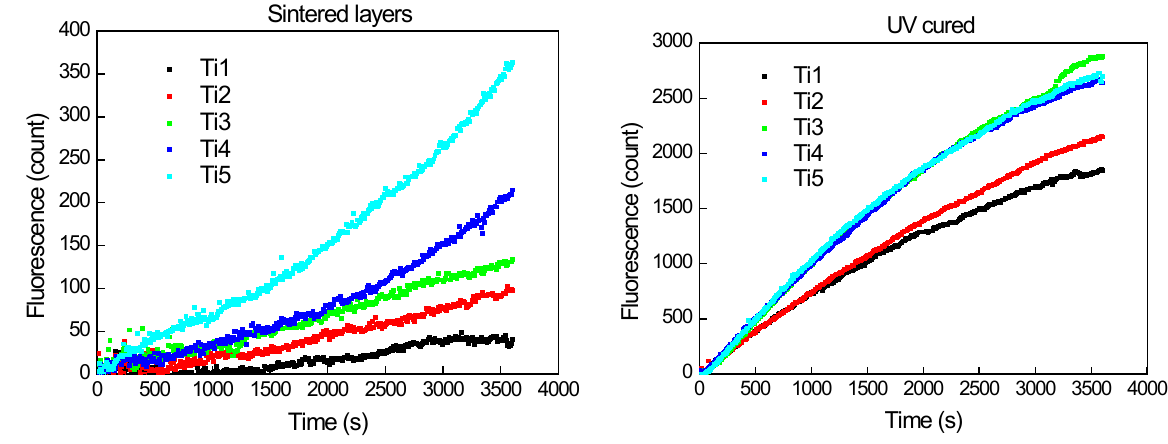
Figure 9. Records of hydroxyterephtalic acid fluorescence intensity vs. irradiation time for sintered ( left ) and UV-Cured ( right ) sample